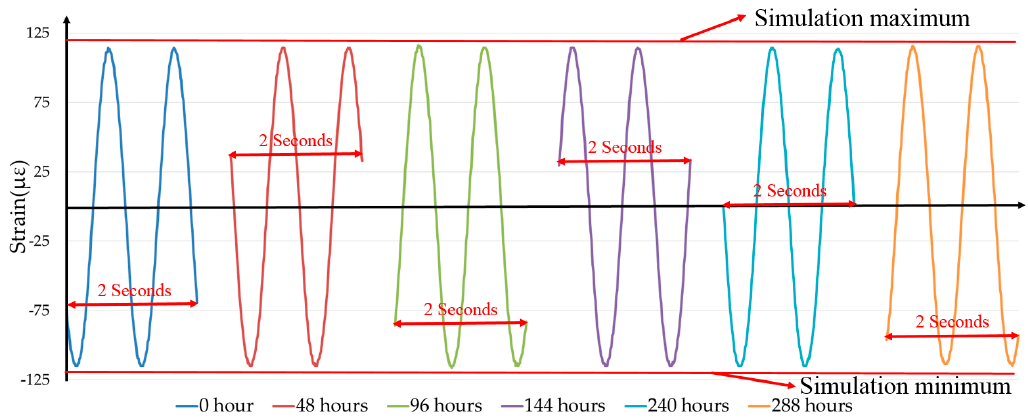
Figure 9. The dynamic strain measurement cycle samples at different time points.